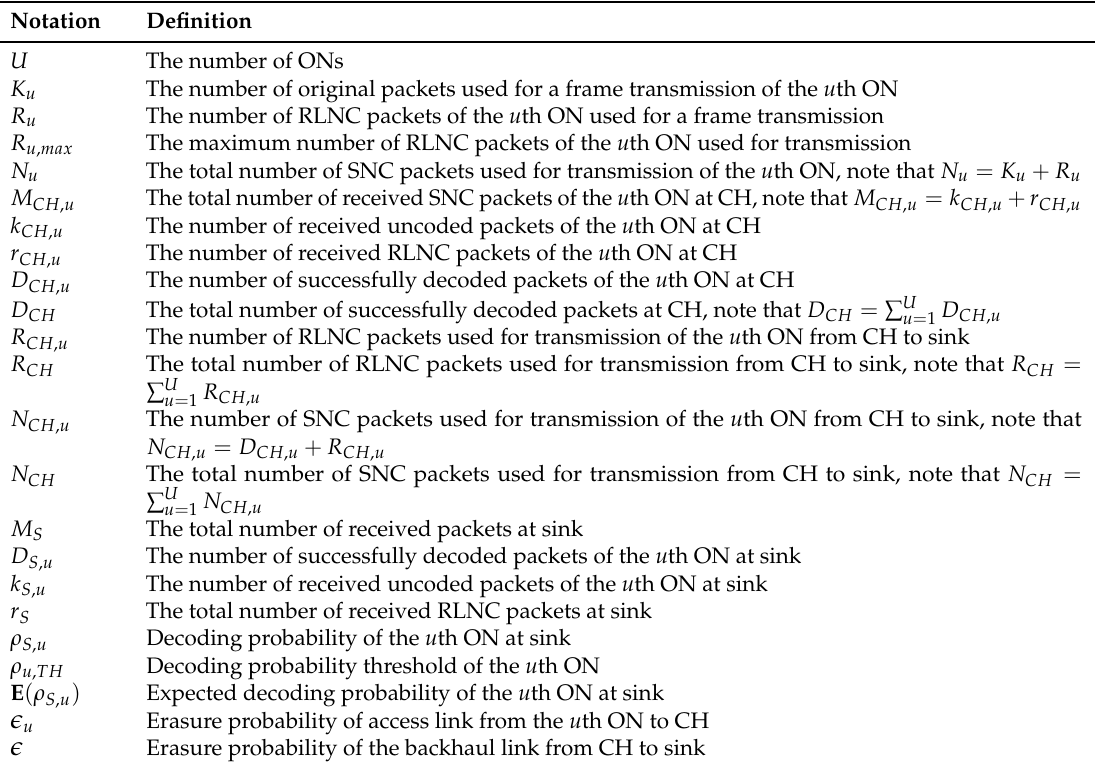
Table 1. Commonly used